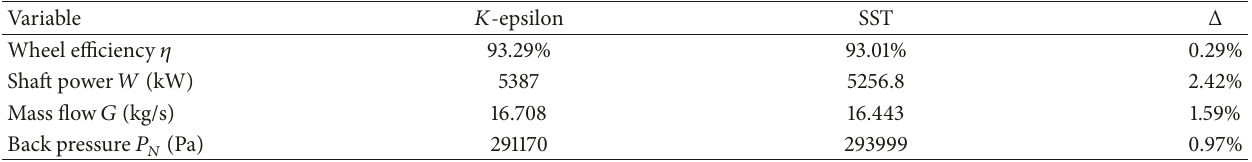
Table 6: The contrast of SST and 𝑘 -epsilon